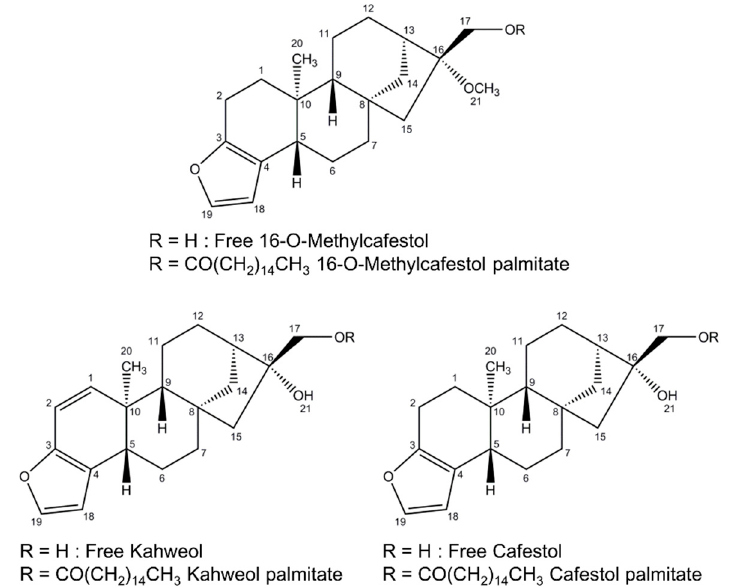
Figure 1. Chemical structures of 16-OMC, kahweol, and cafestol .